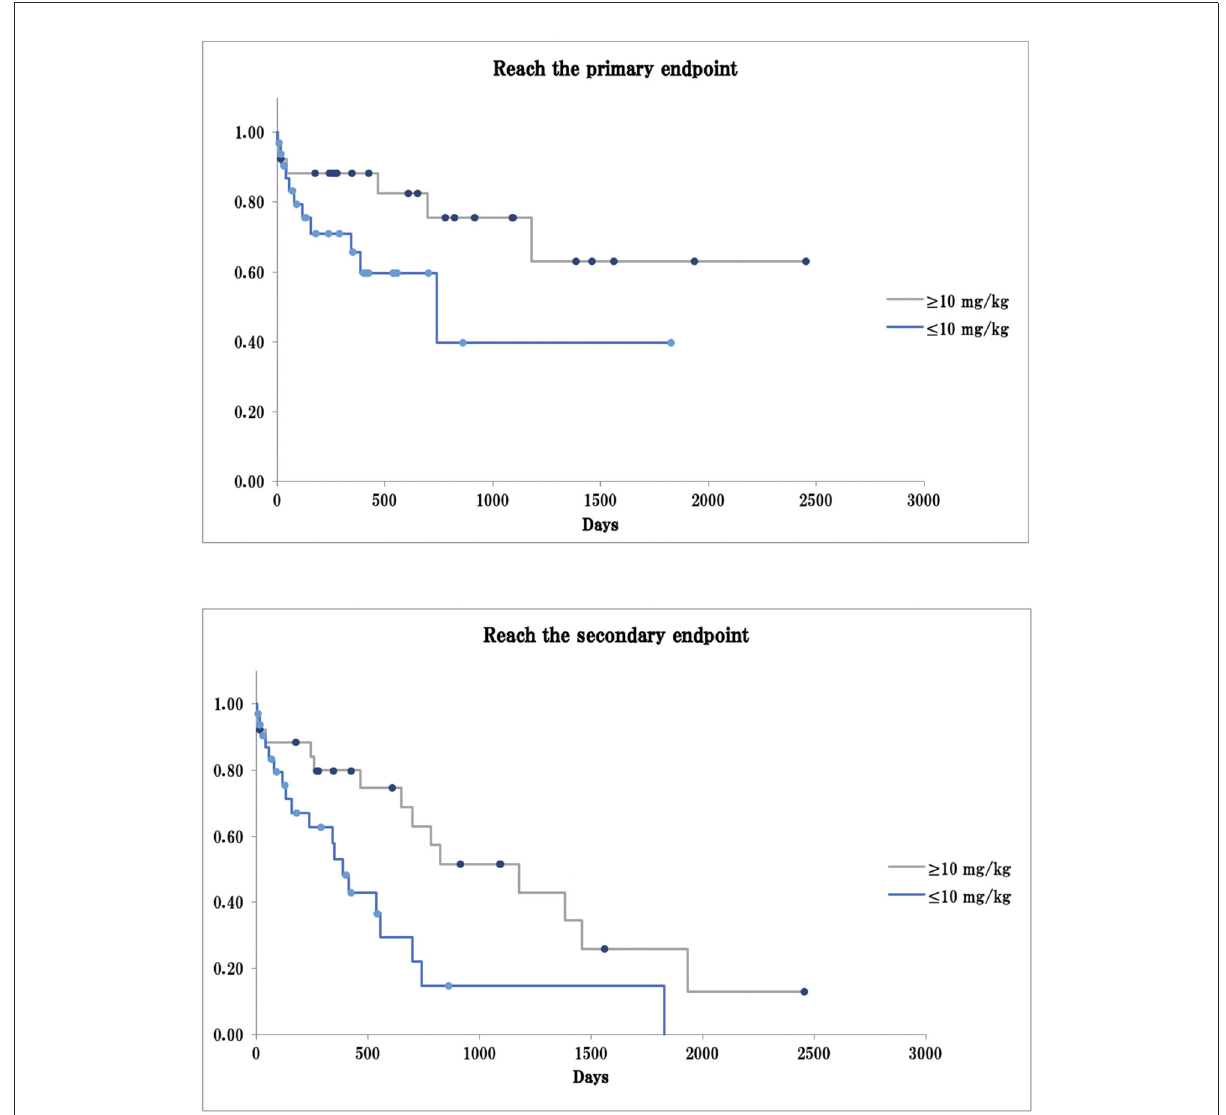
FIGURE2 Survival curve in cilostazol dose ≥ 10 mg/kg or ≤ 10 mg/kg. The primary endpoint: arrhythmia-related death or PMI as a result of bradyarrhythmia that was not controlled by cilostazol; The secondary endpoint: death from any cause, including arrhythmia-related death or PMI; Dot: the data cut-off